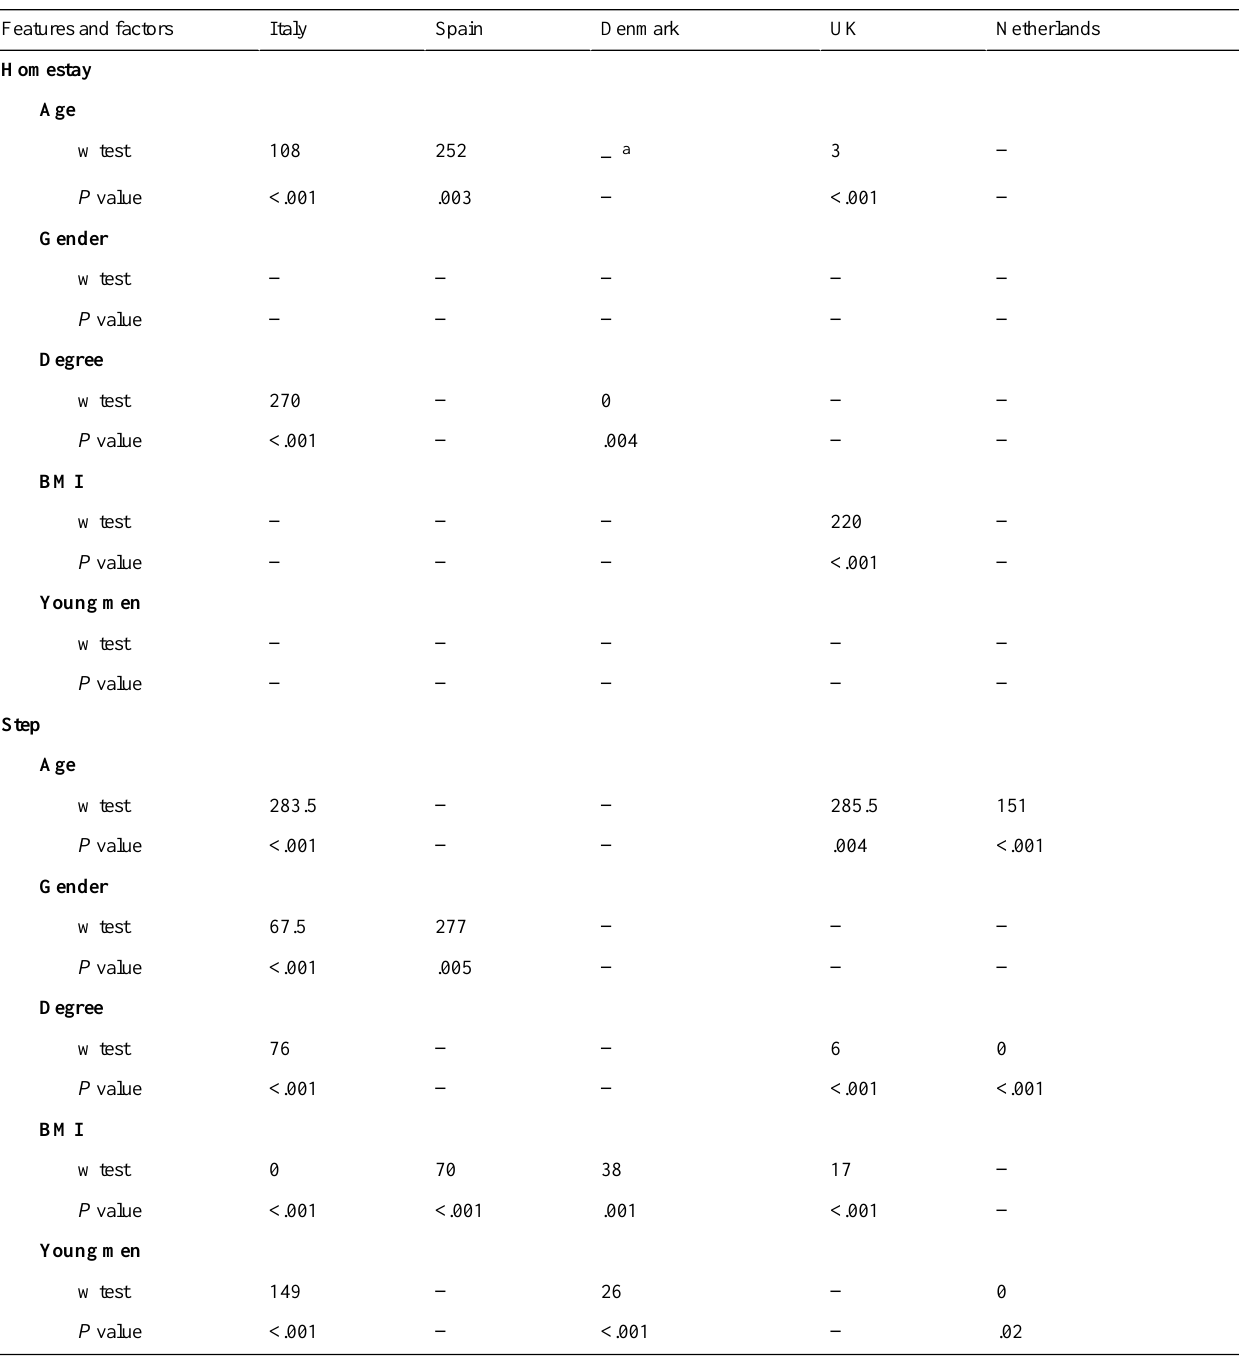
Table 3. Wilcoxon signed rank test results on the examined factors during lockdown periods (only statistically significant differences were reported). NetherlandsUKDenmarkSpainItalyFeatures and